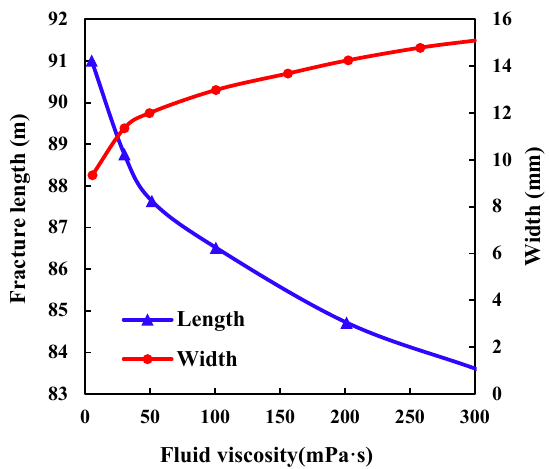
Figure 7. HF length and aperture curves under various fracturing fluid viscosity after injecting for 30 min.